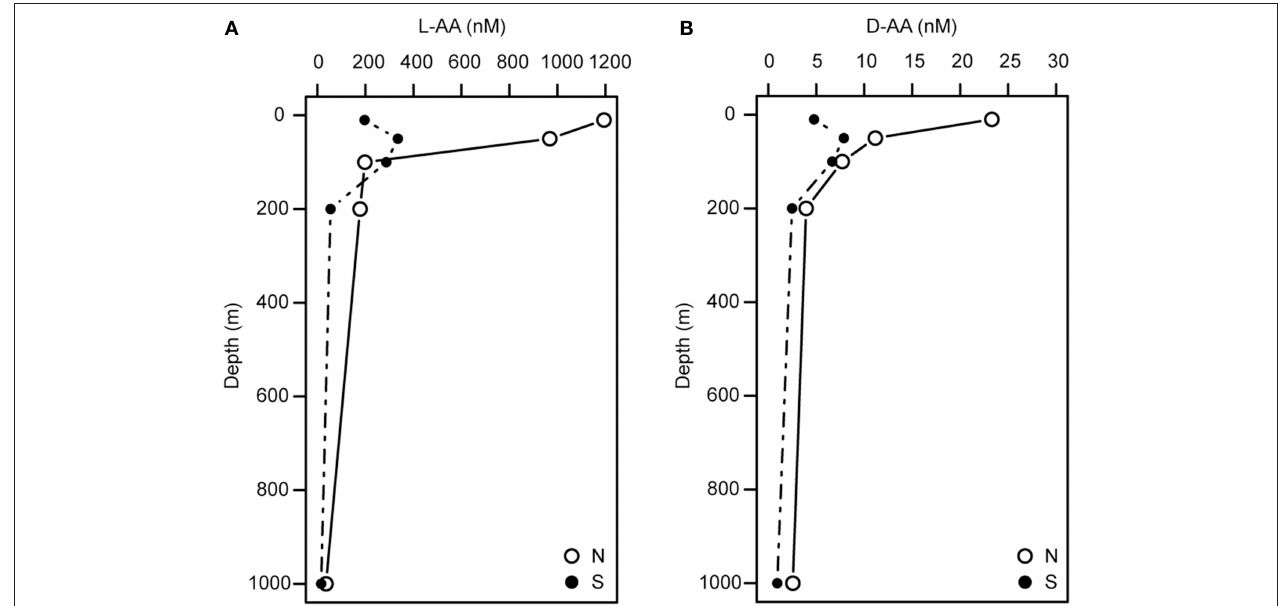
FIGURE 1 | Depth profiles of the concentrations of particulate L-AAs (A) and D-AAs (B) at stations N and